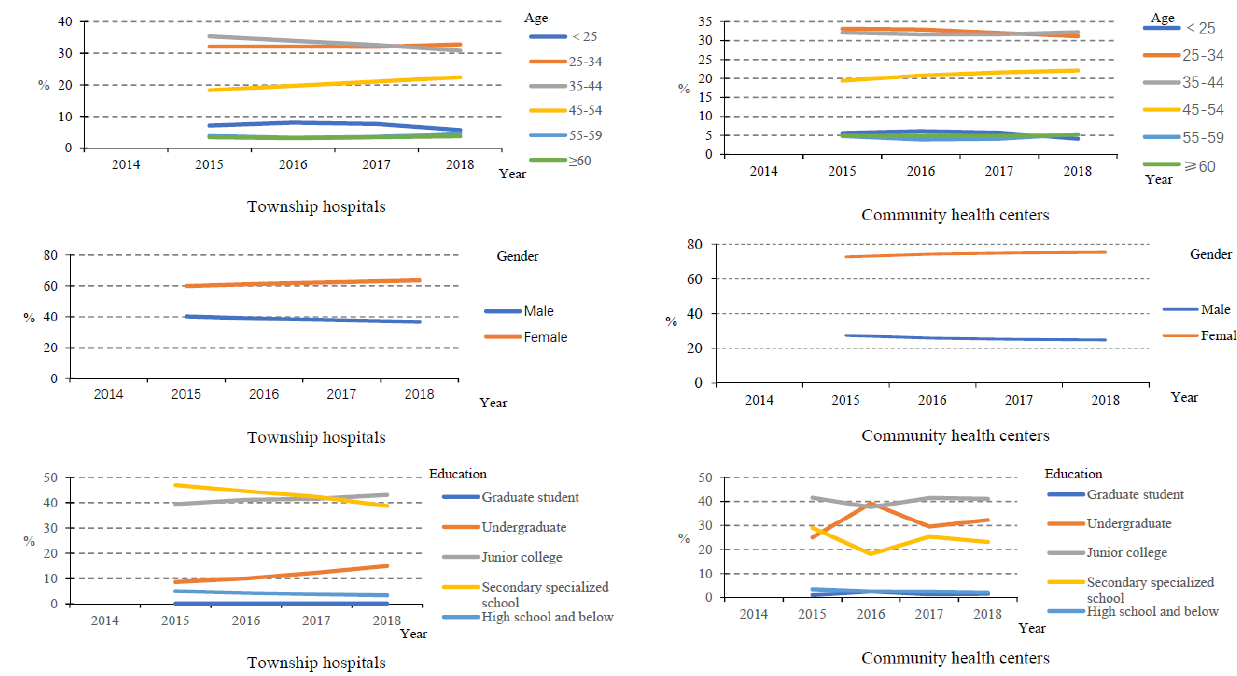
Figure 3. The characteristics of health technicians in PHIs.